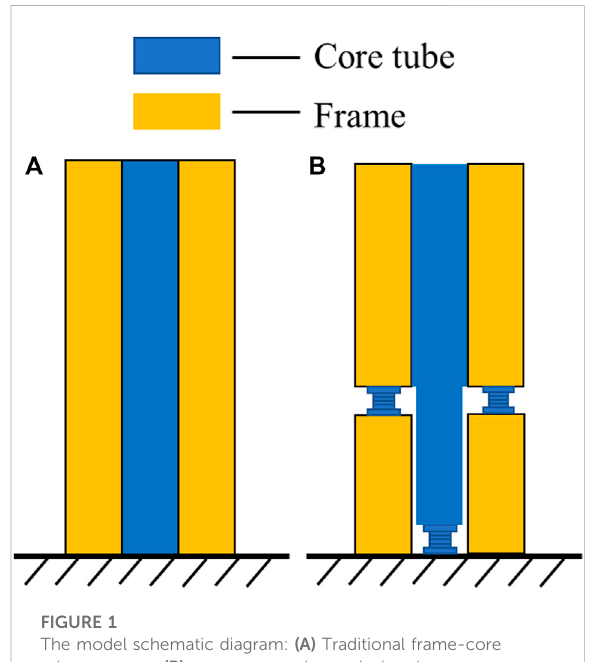
The model schematic diagram: (A) Traditional frame-core tube structure, (B) new staggered story isolated